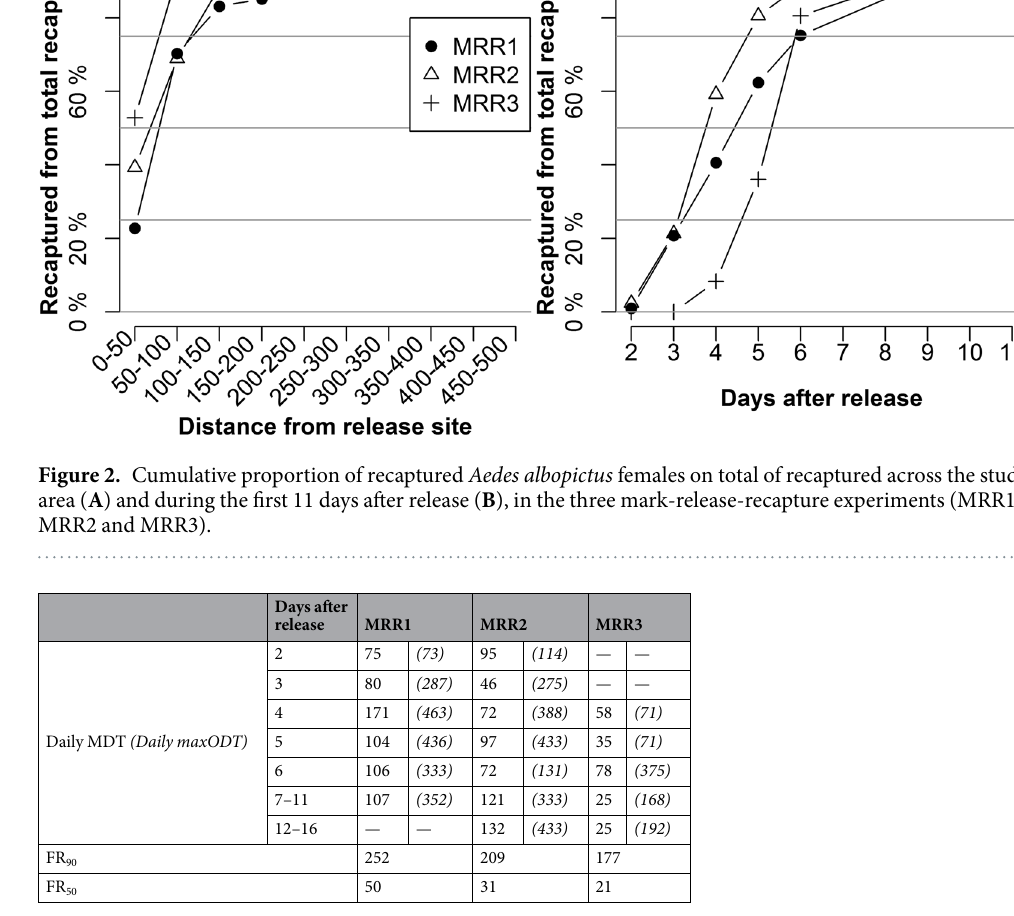
Table 1. Mean distance travelled (MDT), maximum observed distance travelled (maxODT) and flight ranges of 90%